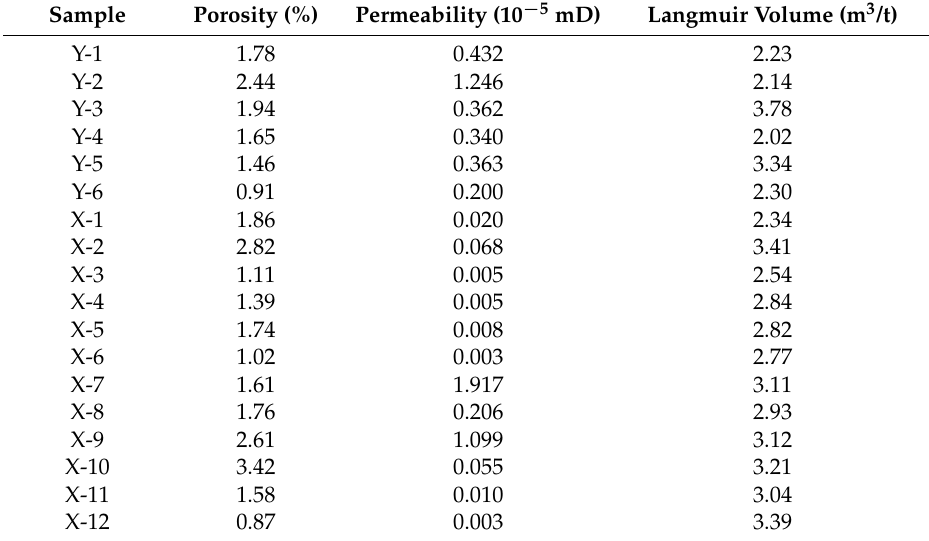
Table 4. Porosity, permeability and methane adsorption capacity of transitional Longtan Shale from YV-1 and samples from YV-1 and XD-1.